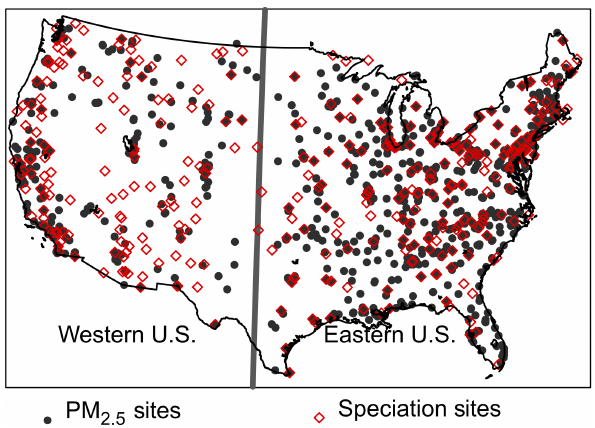
Figure 1. The locations of EPA-AQS sites with measurements that meet the criteria described in Sect. 2.1 in the text. PM 2 . 5 measure- ments are available for the years 1999–2013 (sites are marked by black dots) and speciated aerosol (SO 2 − OC) concentrations are available over years of 2000–2013 (sites are marked by red diamonds). The grey solid line defines the western US (west of 100 ◦ W) and eastern US (east of 100 ◦